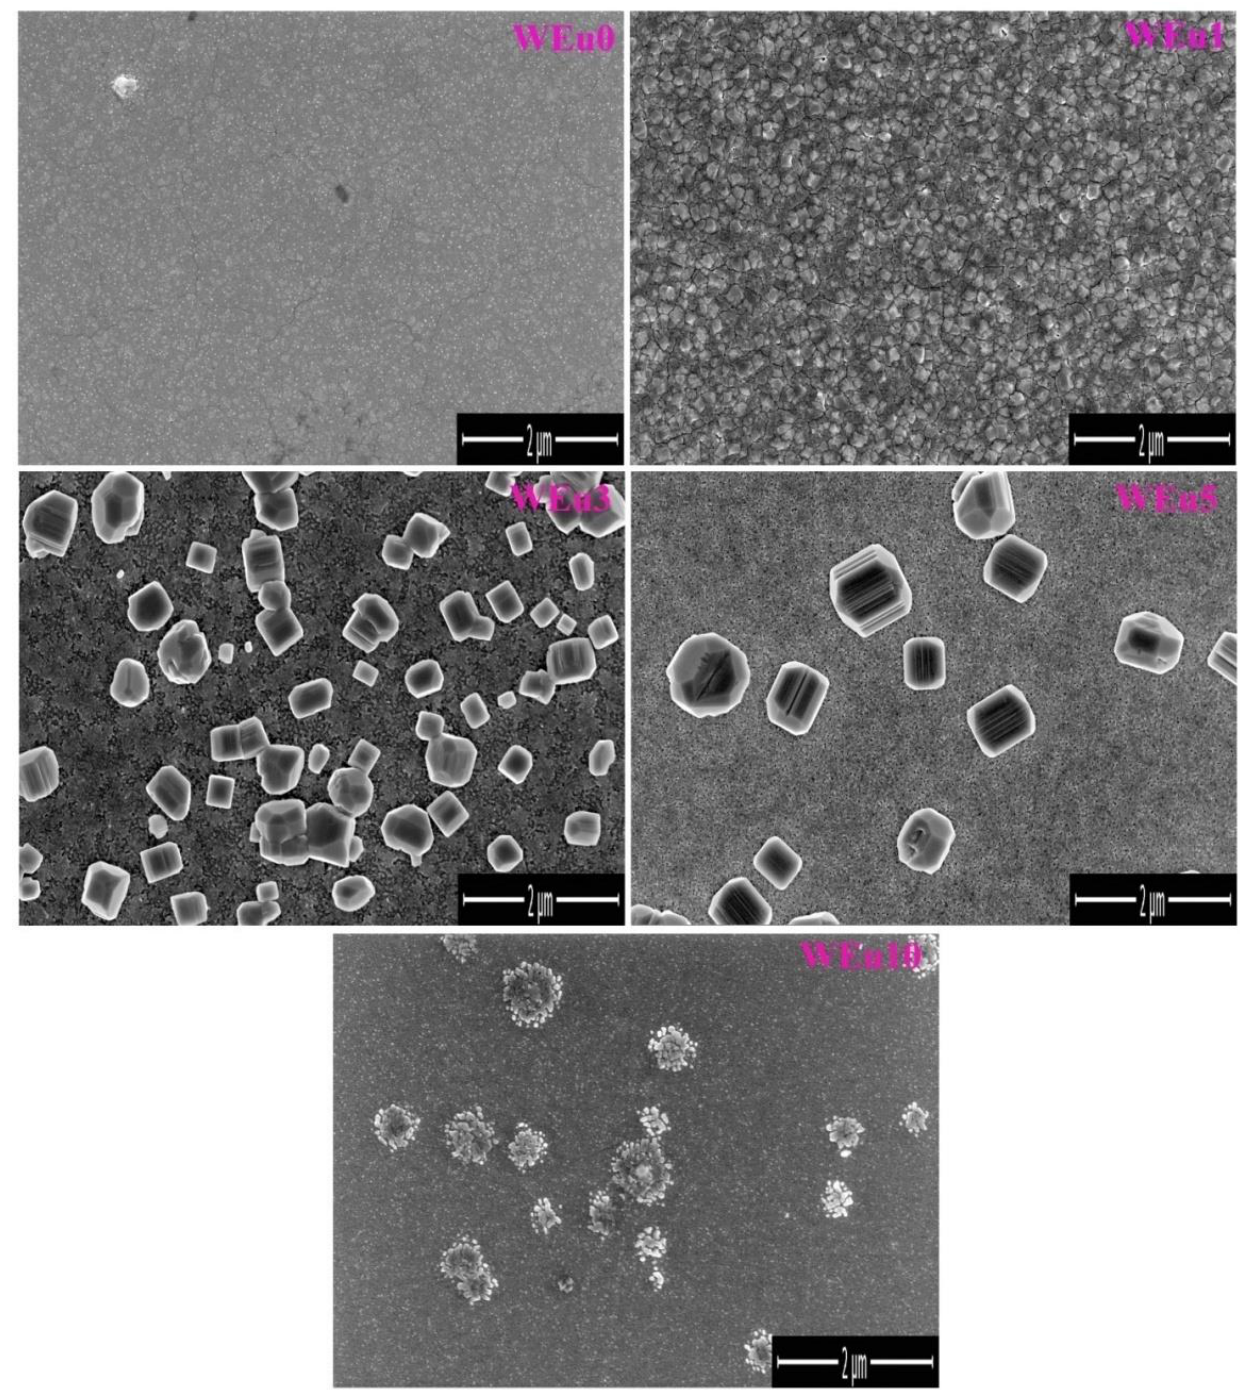
Figure 4. FESEM images of the un-doped and Eu 3+ -embedded WO 3 films annealed at a temperature of 600 °C.